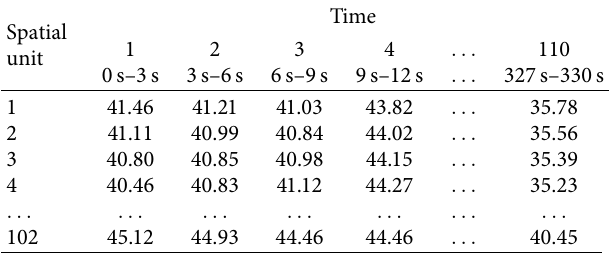
Figure 2: Grid division of road sections. Table 1: Samples of average speeds of spatial units (unit: km/h).